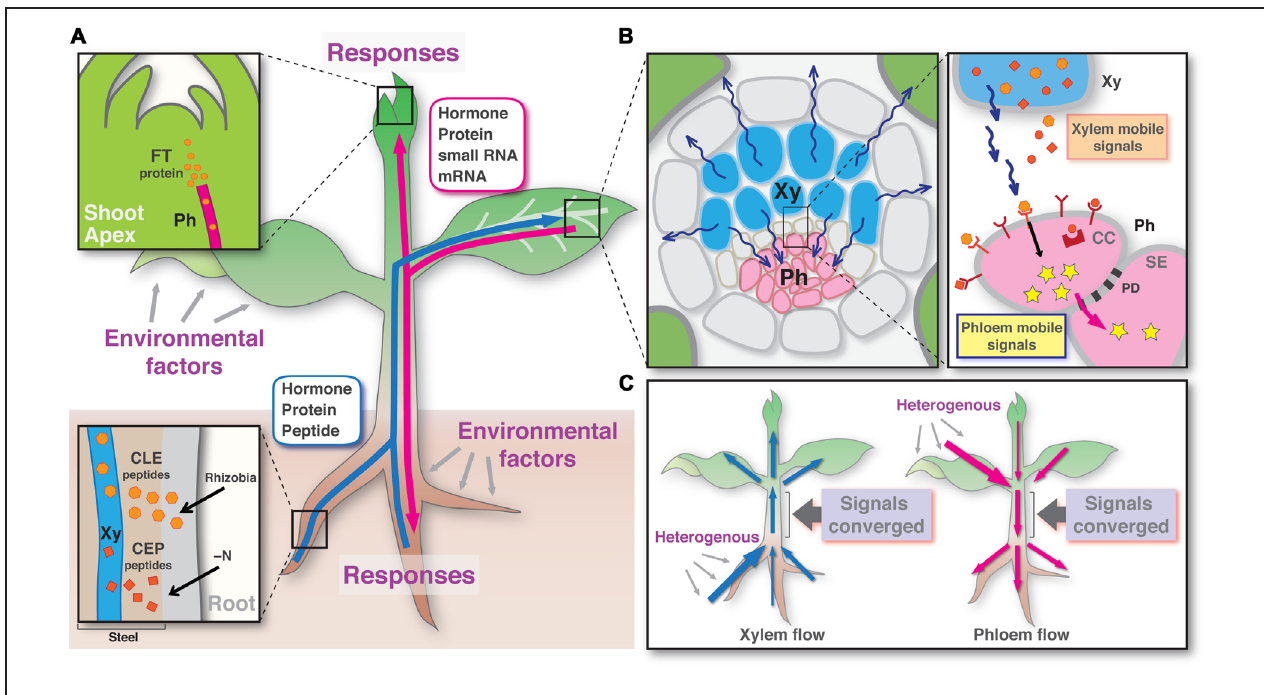
FIGURE 1 | A model of long-distance signaling via plant vascular tissues. (A) Potential signal molecules of the xylem (blue) and the phloem (red) translocation pathways. Insets show xylem loading and phloem unloading of signal molecules in the sink tissues. (B) Signal